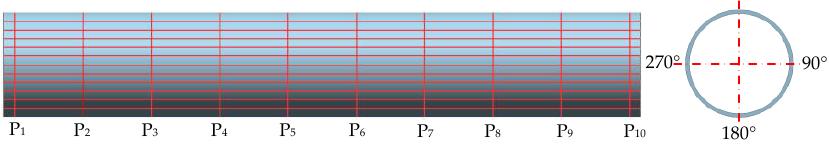
Figure 3. Schematic diagram of wall thickness